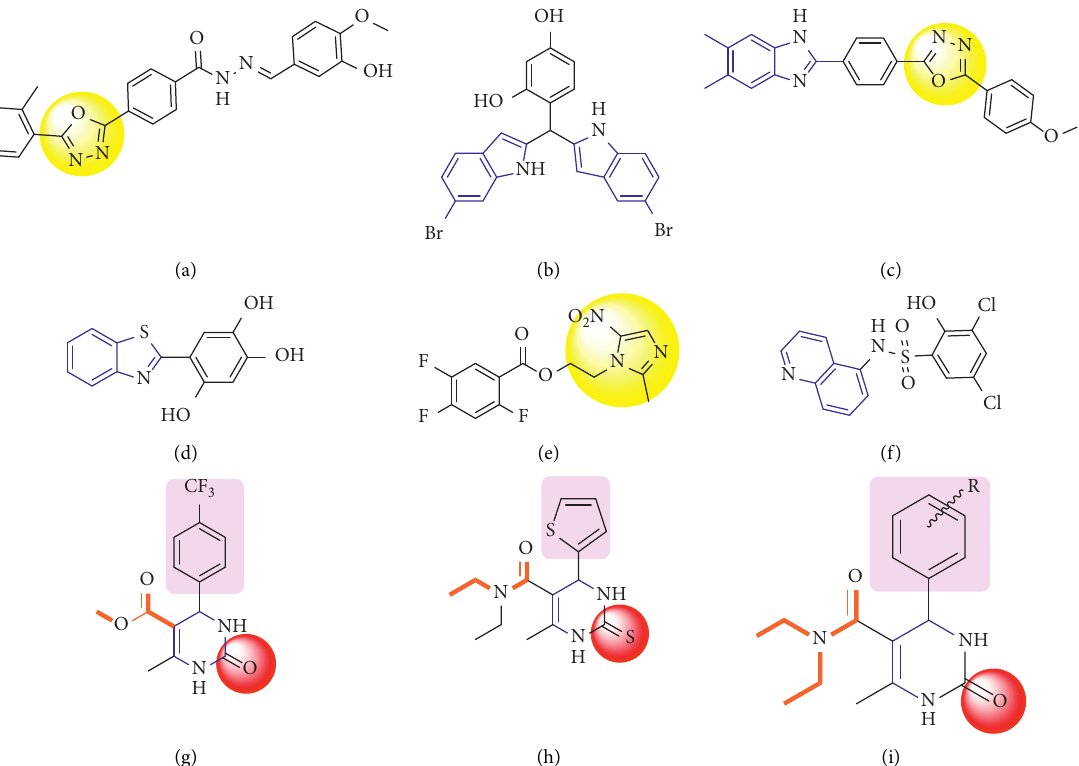
Figure 1: Identified leads for β -glucuronidase inhibition. (a) IC IC 50 � 2.26 ± 0.06 μ M, (e) IC 50 � 1.20 ± 0.01 μ M, (f) IC 50 � 1.60 ± 0.10 μ M, (g) IC 50 � 9.38 ± 0.15 μ M, (h) IC 50 � 0.35 ± 0.09 μ M, (i) new design